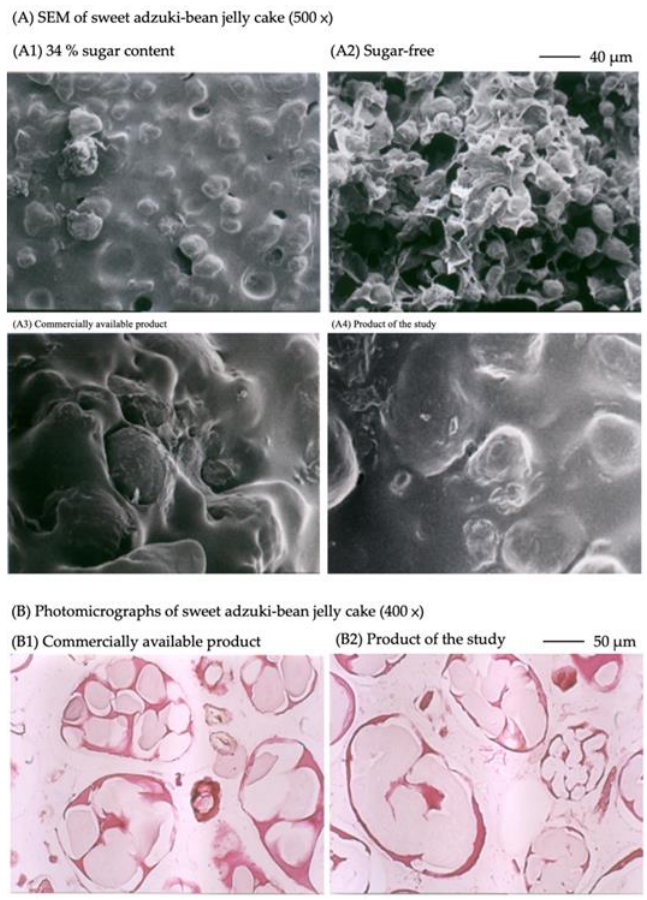
Figure 5. SEM micrographs and photomicrographs of sweet adzuki-bean jelly cake.